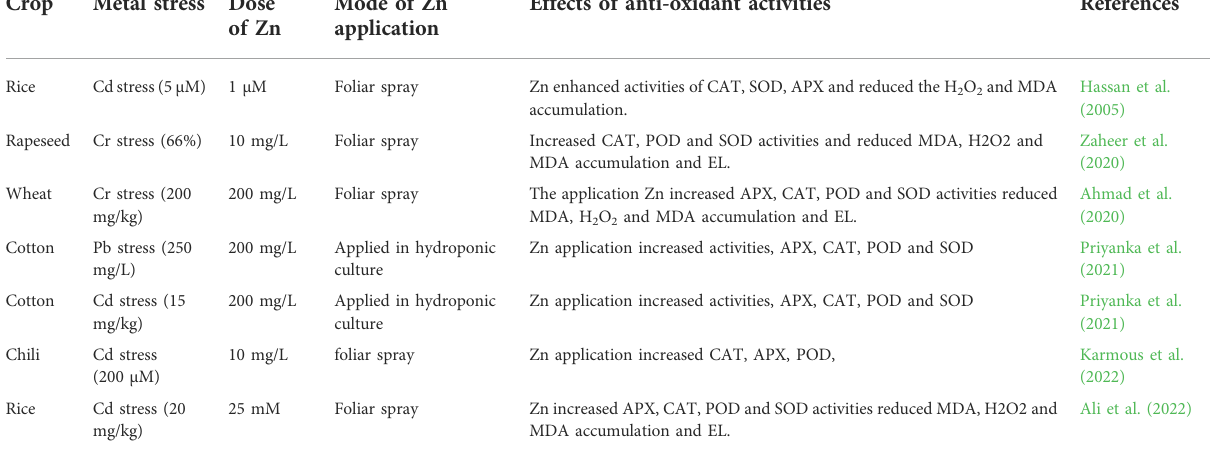
TABLE 2 Effect of Zn on anti-oxidant activities and oxidative stress indicators of different crops under metal stress